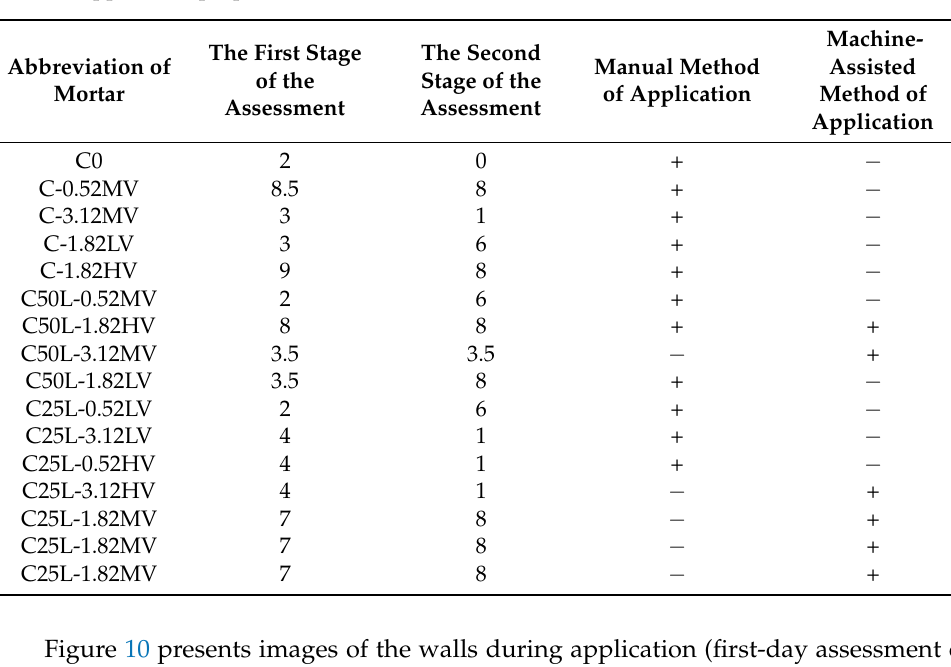
Table 9. Application properties of mortars.